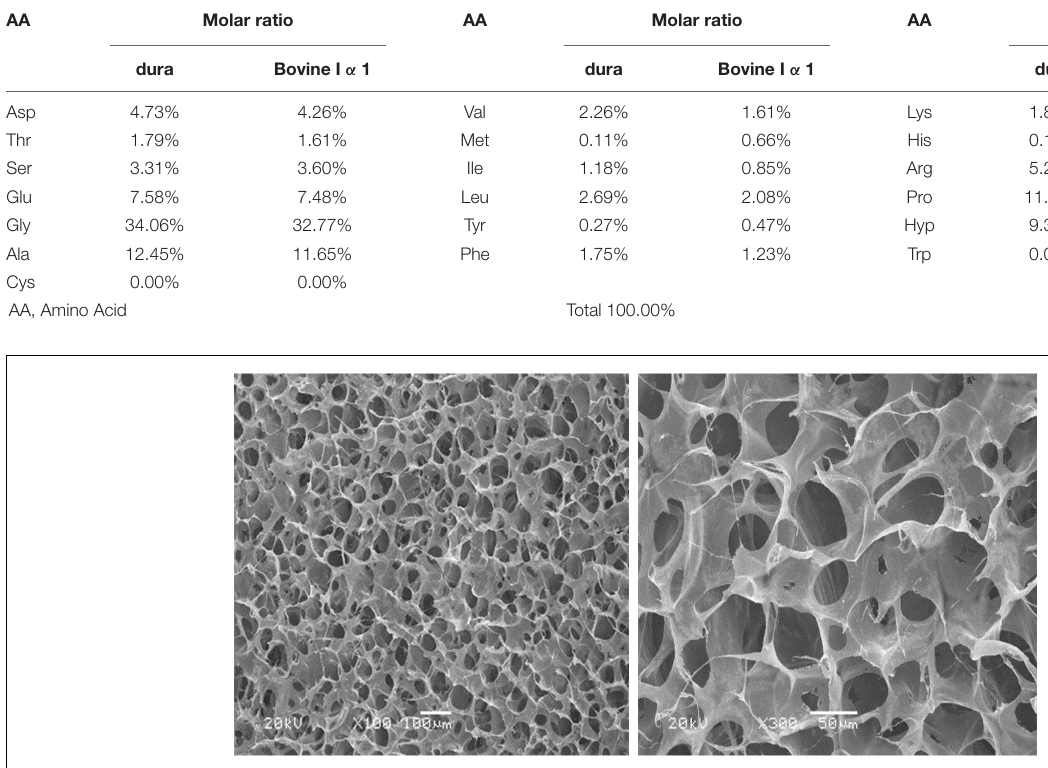
FIGURE 3 | The microstructure of dura substitute.